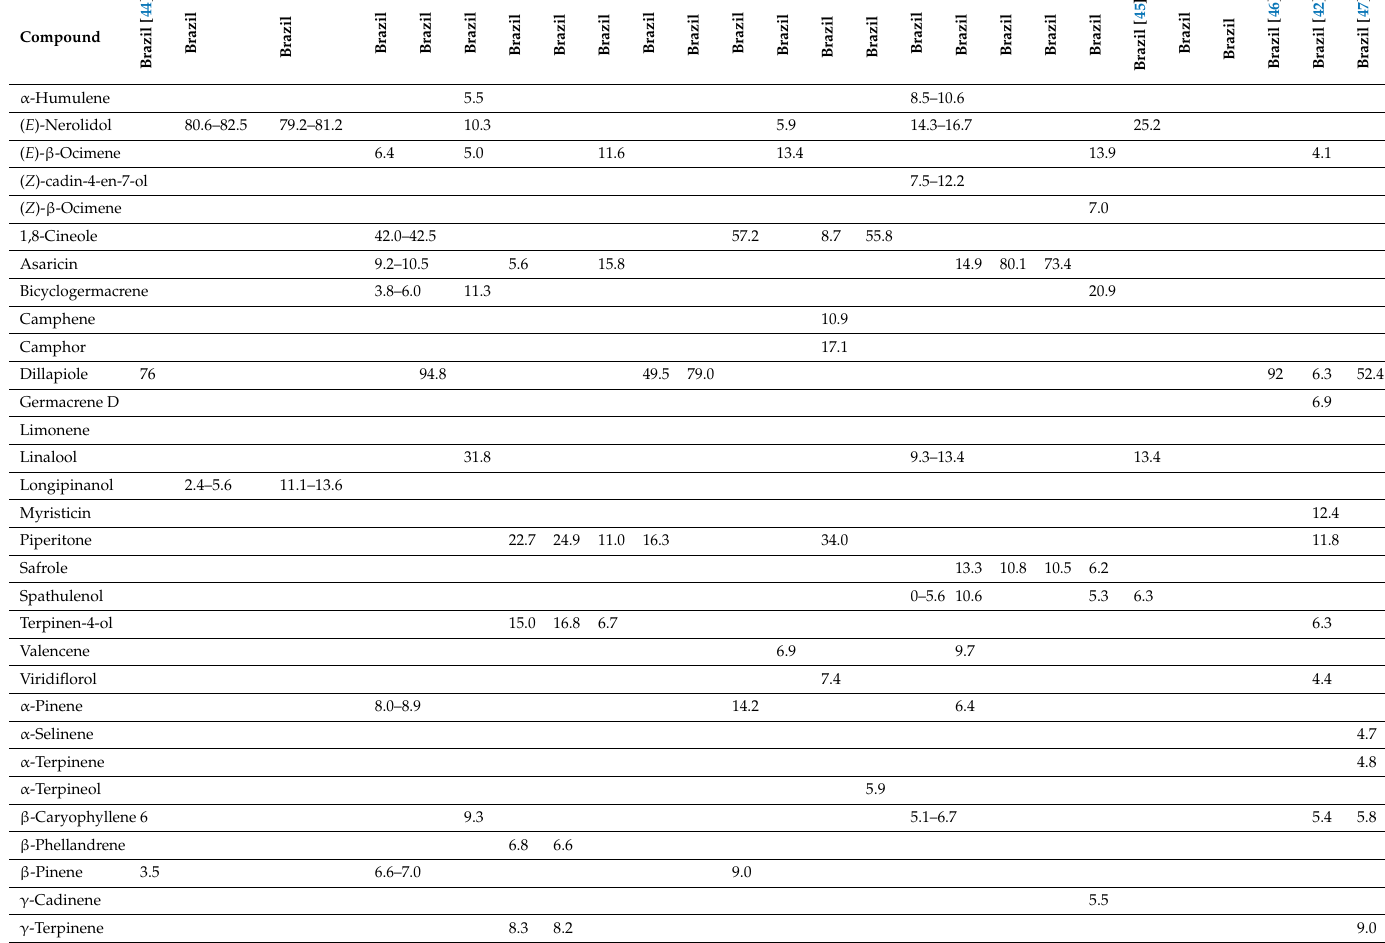
Table 1. Chemical compositions (%) of Brazilian Piper aduncum leaf essential